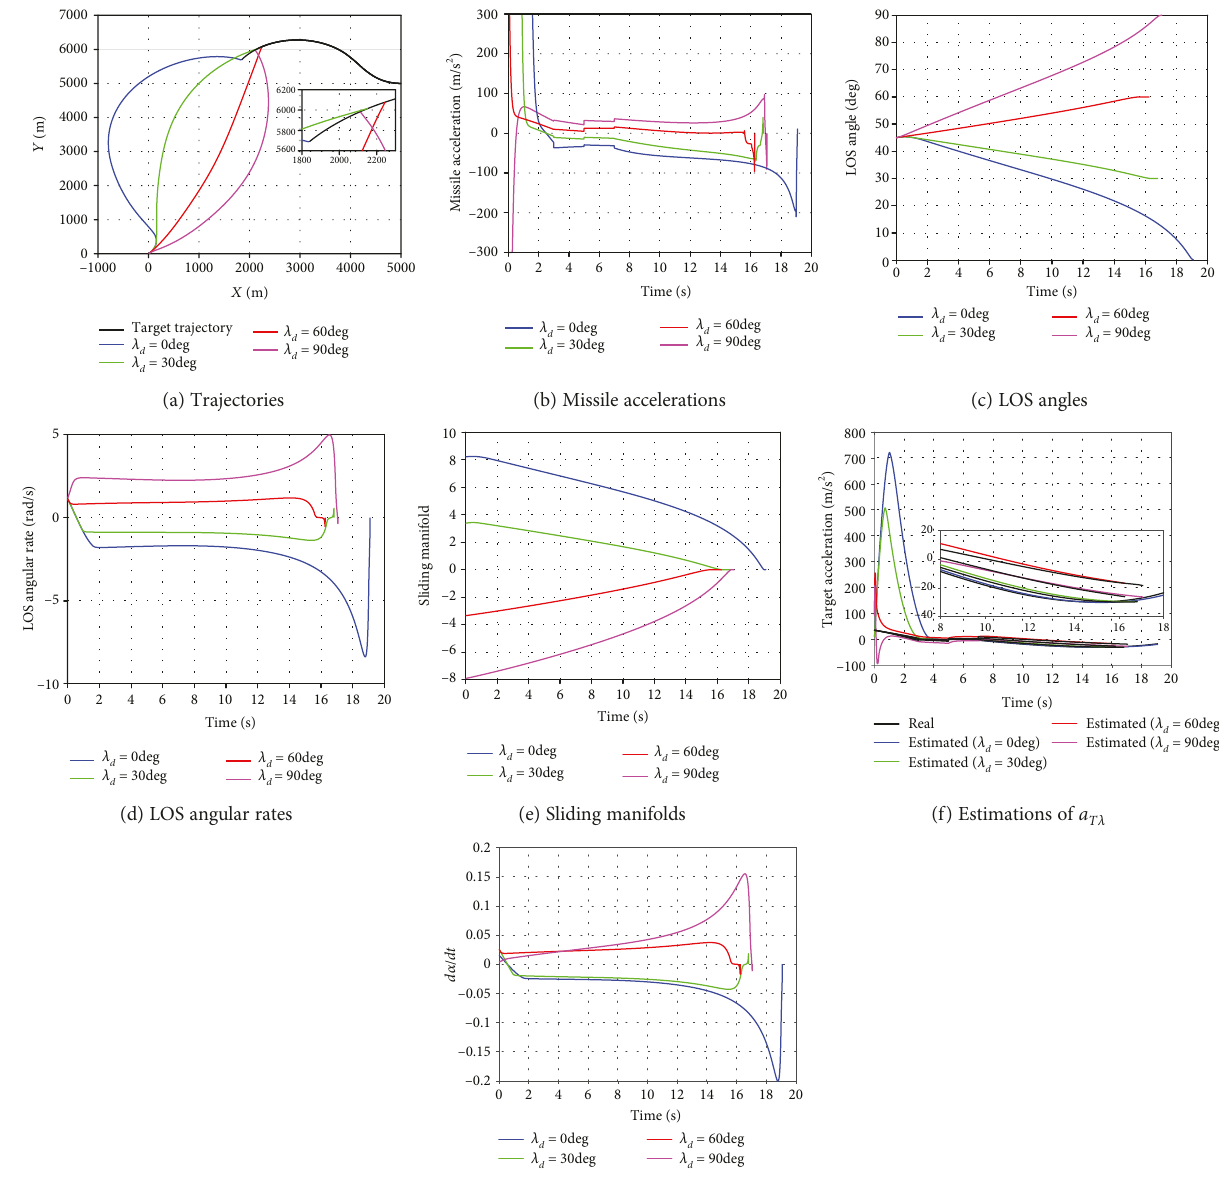
Figure 5: Simulation results of case